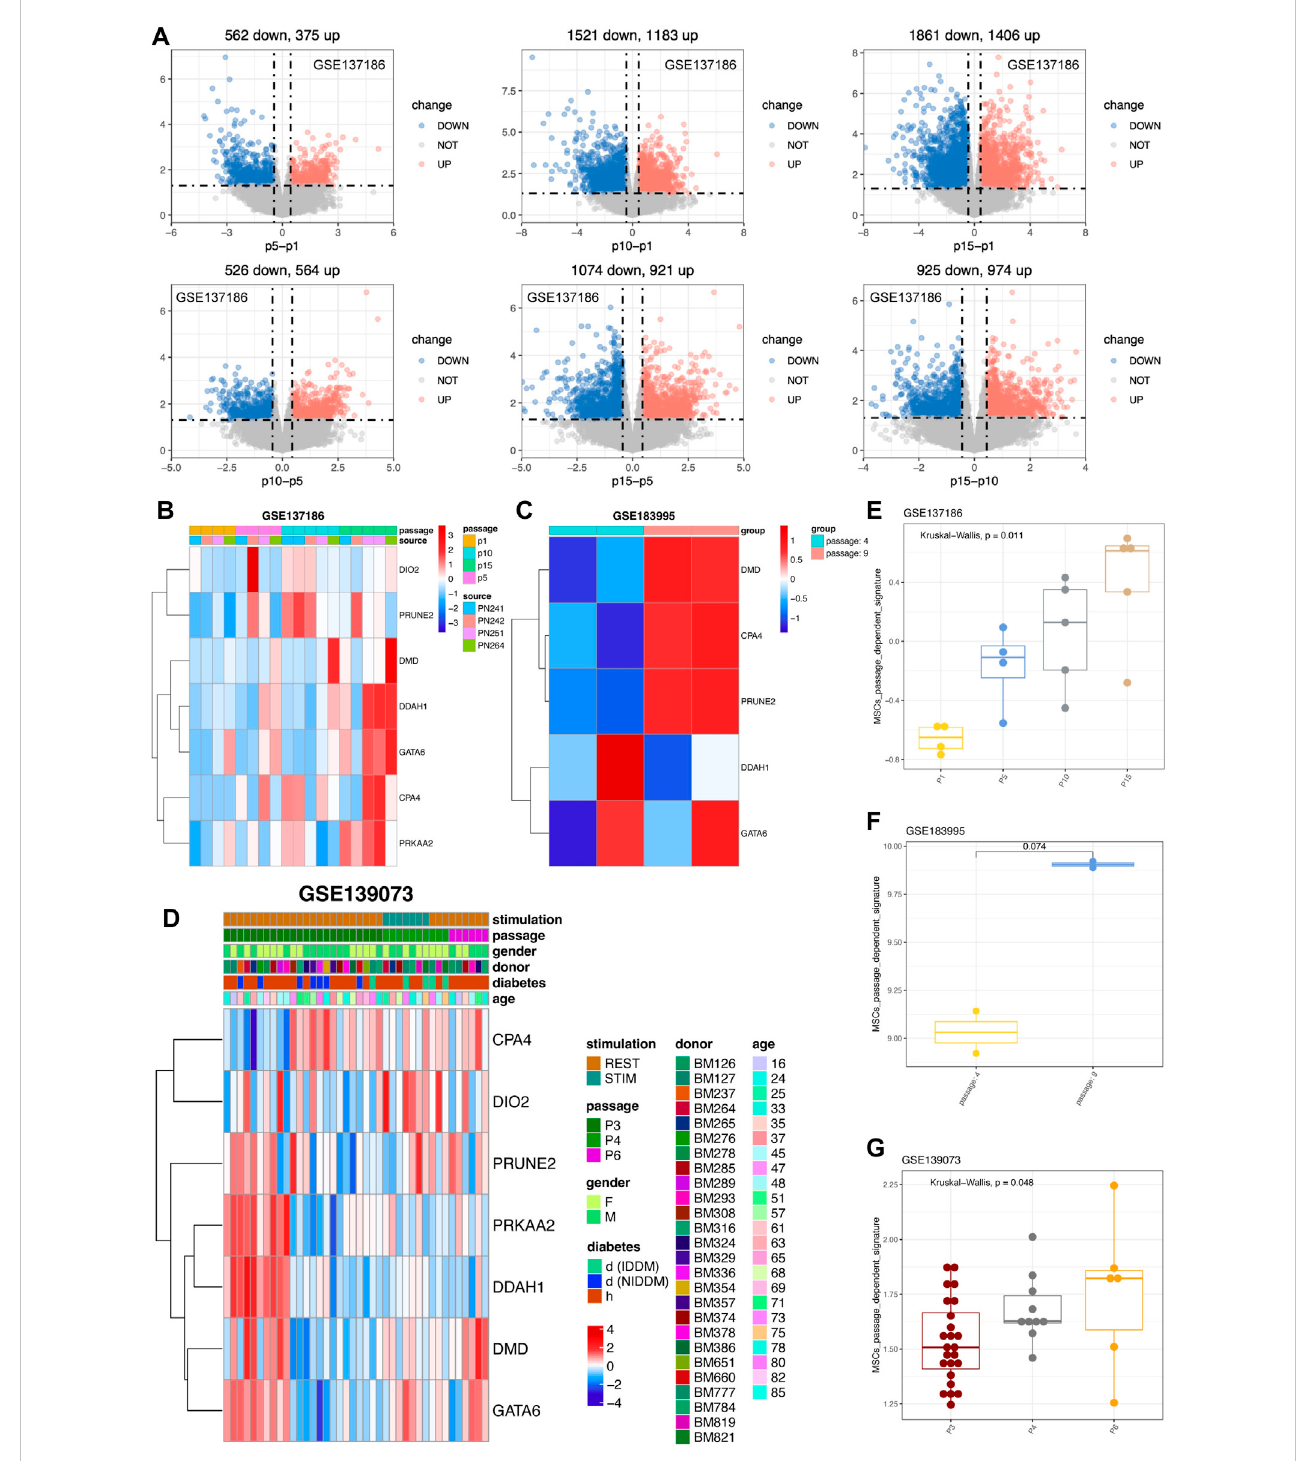
FIGURE 6 ValidationofsevengenesinexternalcohortsrelatedtovariouspassagesofMSCs. (A) DifferentialanalysisofvariousMSCsderivedfromdifferentpassages in GSE137186. The upregulated genes were in red color while the downregulated genes were in blue. (B) Expression pattern of seven genes in GSE137186, containing CPA4, DMD, PRKAA2, DDAH1, DIO2, GATA6 and PRUNE2. (C) Expression pattern of hub genes in GSE183995 and the statistical analysis were performed. (D) Expression pattern of seven genes in GSE139073. (E) Signature score of seven genes in GSE137186. (F) Signature score of hub genes in GSE183995. (G) Signature score of seven genes in GSE139073 and the statistical analysis were